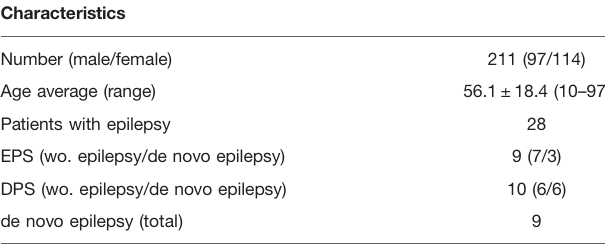
TABLE 1 | Clinical